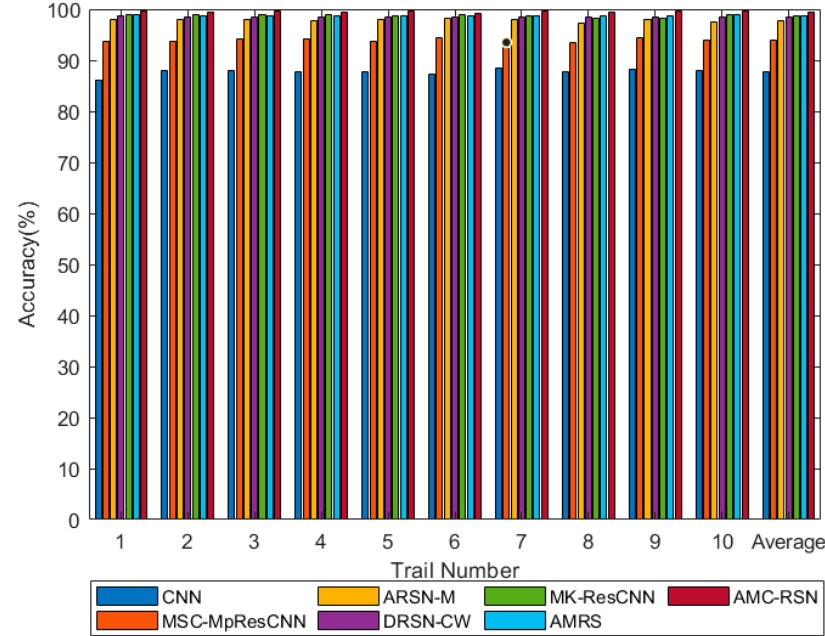
Figure 10. Diagnostic results of different models for the Mixed datasets. Table 6. Fault diagnosis results in gear.